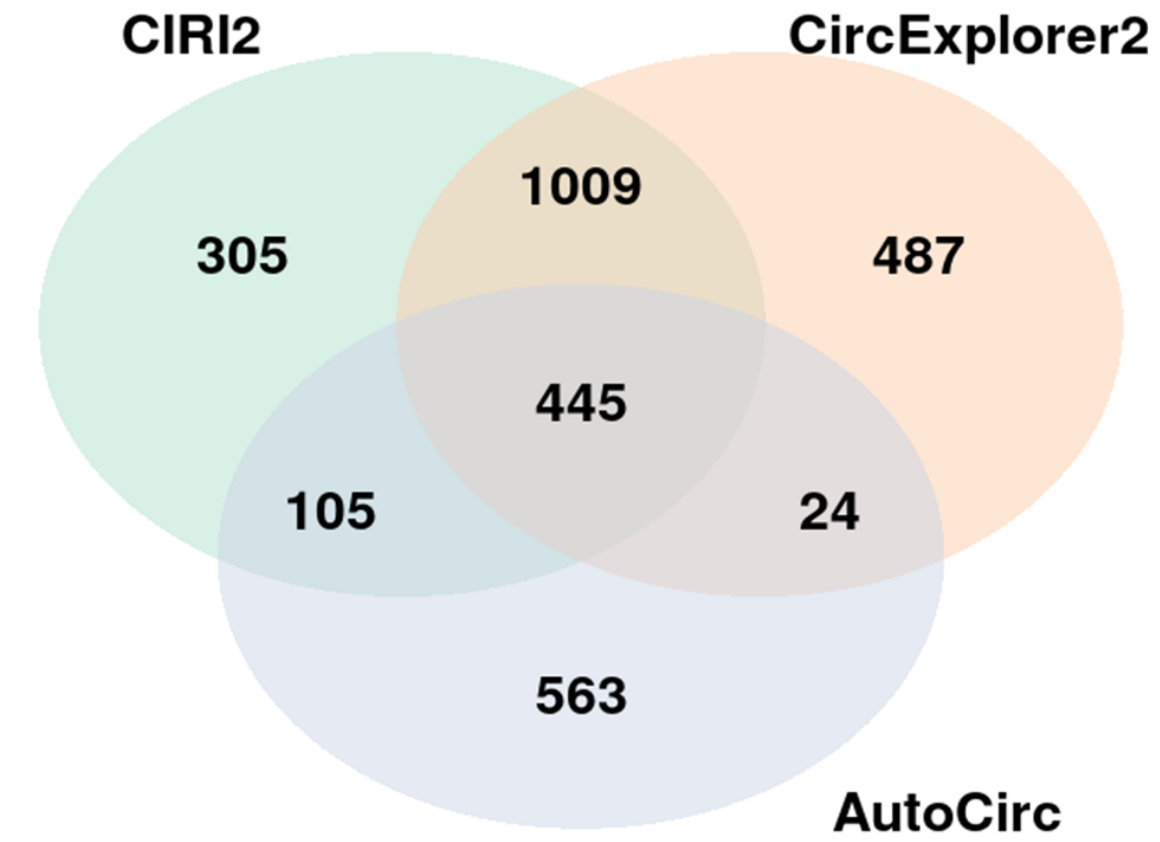
Figure 1. Number of circRNAs found by the three circRNA detecting tools.